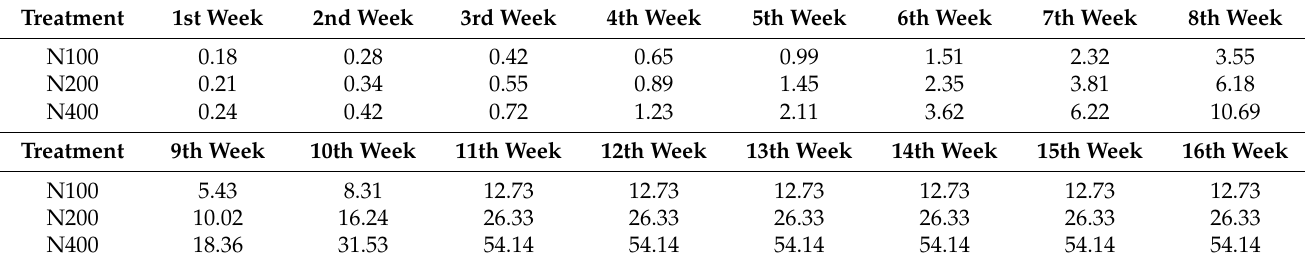
Table 1. Weekly exponential nitrogen application amount (mg N/plant), including 15 N-urea during nursery production. Treatment